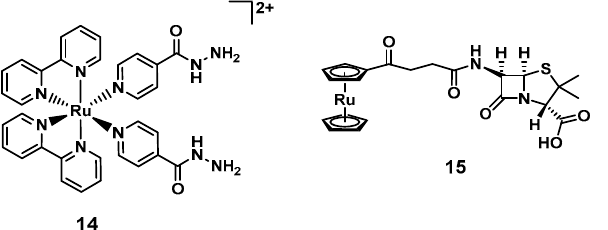
Figure 6. Ruthenium polypyridyl complex with light-triggered isoniazid ligand release ( 14 ) and a ruthenocene derivative of a β -lactam ( 15 ).